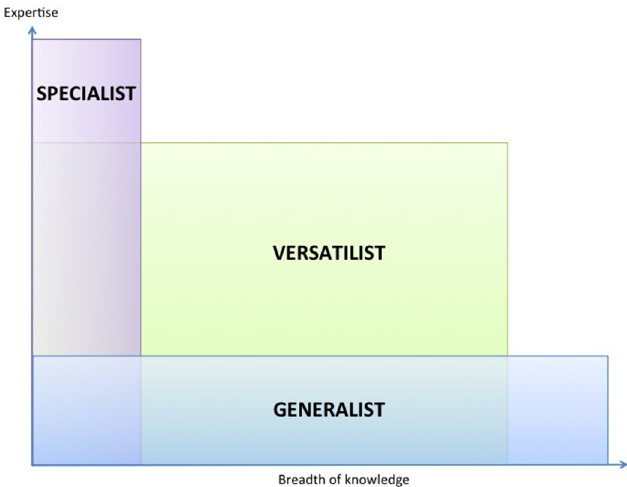
Fig. 1. Graphical illustration of the differences in expertise and breadth of knowledge between a generalist ( e.g. general dental practitioner), a versatilist ( e.g. oral surgeon) and a specialist ( e.g.